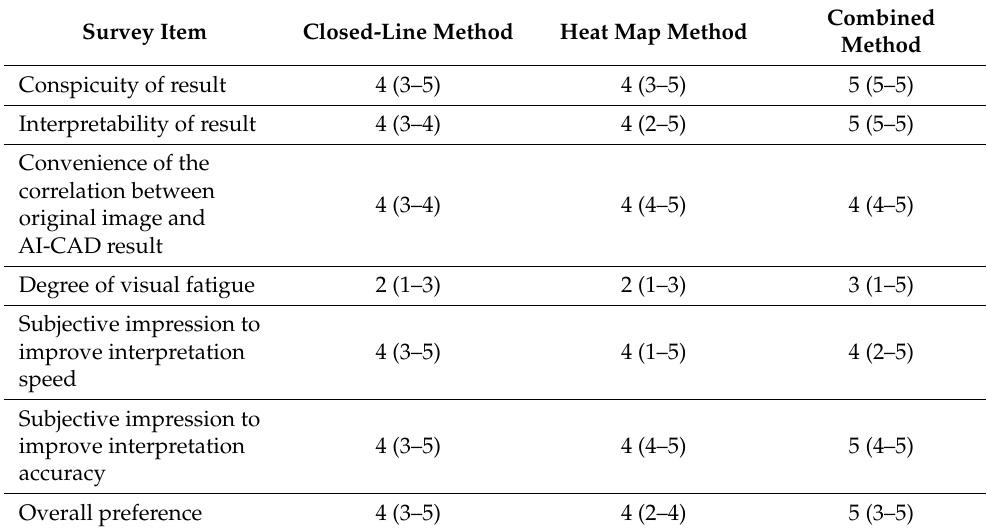
Table 6. Result of preference survey of the three visualizing